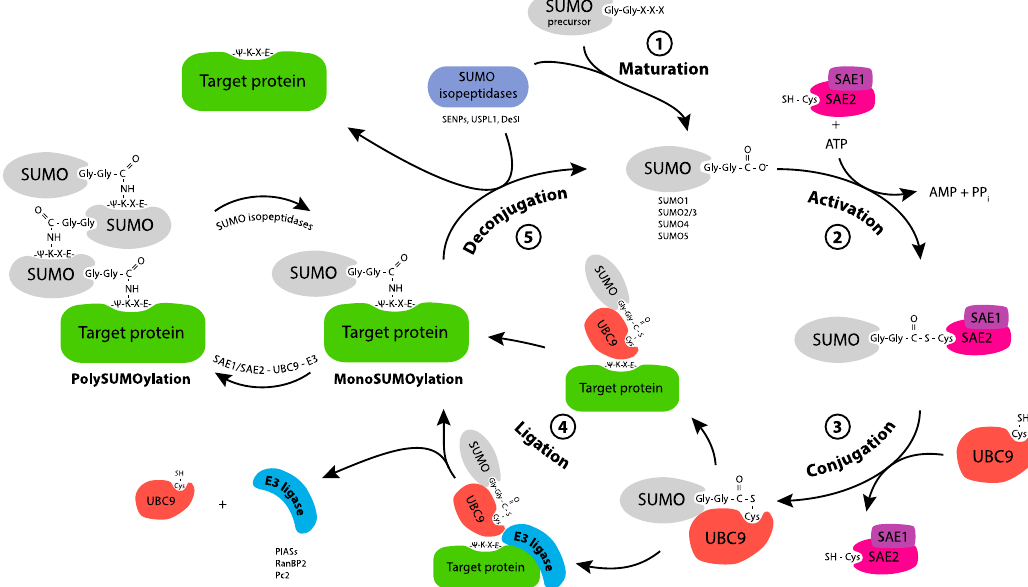
Figure 1. SUMO conjugation / deconjugation cycle. SUMO-1, -2, -3 precursors are maturated through the action of SUMO isopeptidases, which cleave the C-terminus of SUMO to reveal a Gly-Gly motif (1. Maturation). Mature SUMO is activated by forming an ATP-dependent thioester bond between its C terminal Glycine and the catalytic Cys of the E1 enzyme, the heterodimer SAE1 / SAE2 (2. Activation). Activated SUMO is transferred, through trans-thiolation, to the catalytic cysteine of the E2 enzyme, Ubc9 (3. Conjugation). Ubc9 triggers the enzymatic transfer to the Lys (K) of the target protein, either alone or with the help of a SUMO E3 ligase through the formation of an isopeptide bond (4. Ligation). The target protein can be monoSUMOylated, multi and / or polySUMOylated. SUMO isopeptidases cleave SUMO from its substrate and thereby release free SUMO (5. Deconjugation).